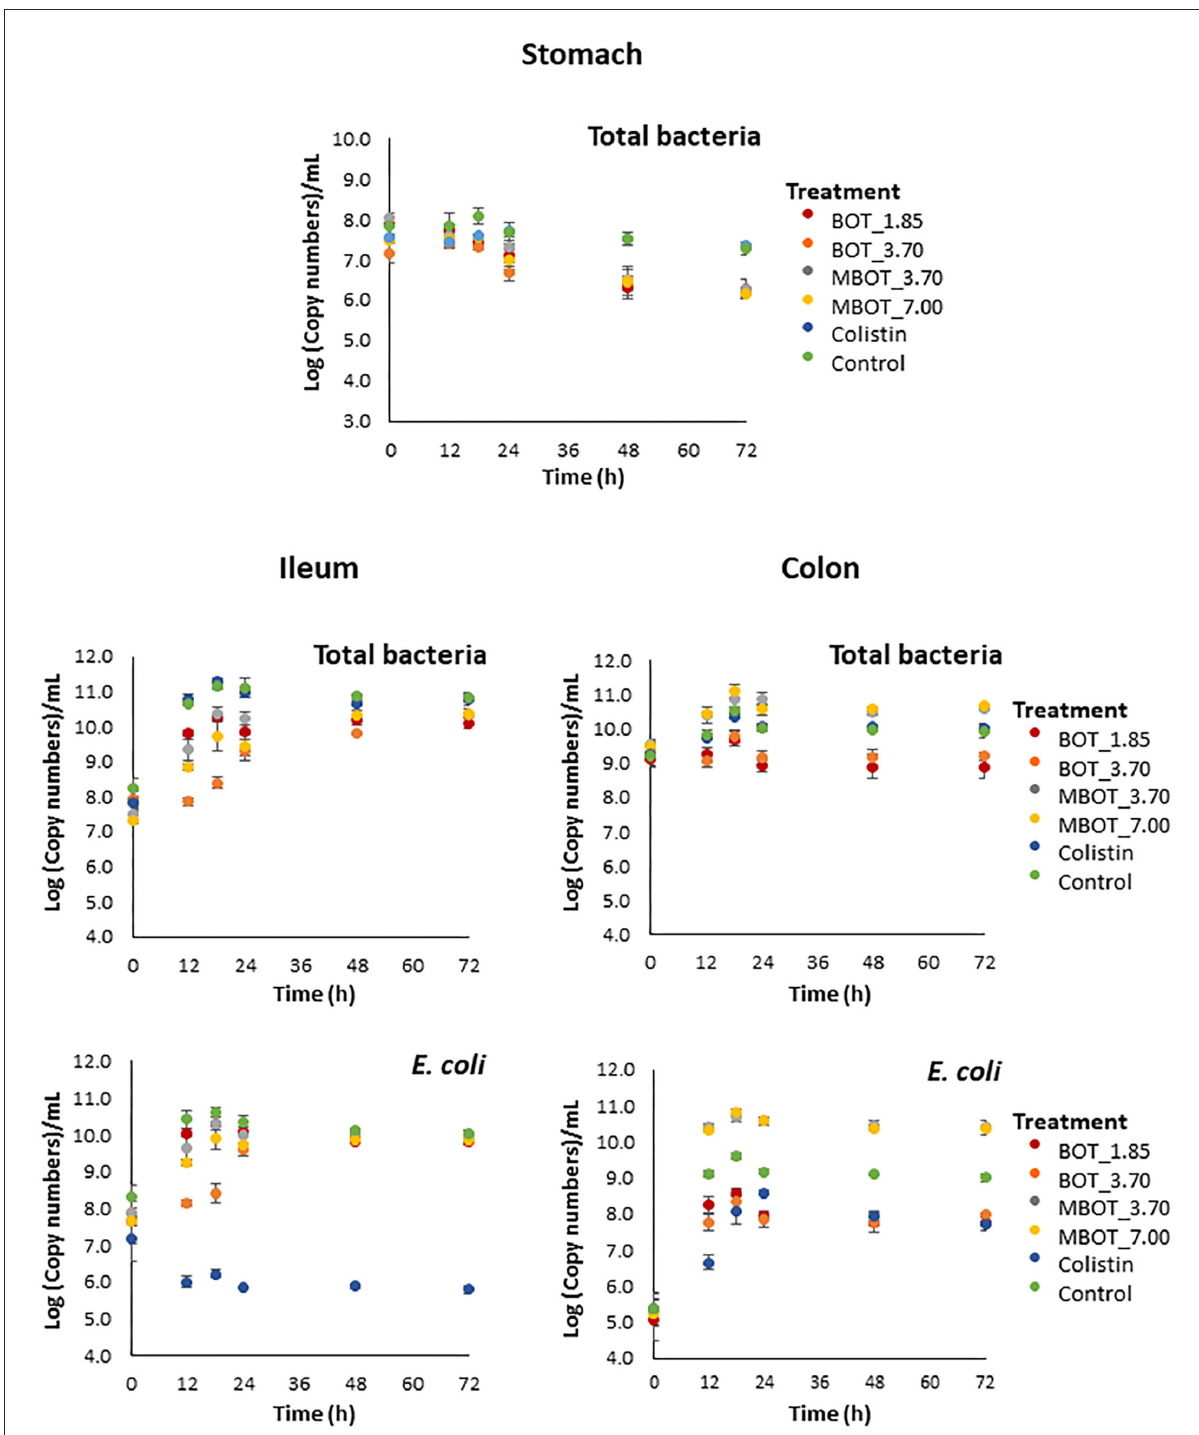
FIGURE1 Total bacteria and E. coli kinetics based on the 16S rRNA gene copy numbers (Log 10 [copies]/mL) by the effect of the unprotected BOT, microencapsulated BOT (MBOT) and colistin on pig simulated stomach, ileum, and colon fermentations. Data shown are the average of triplicate incubations, with error bars indicating standard